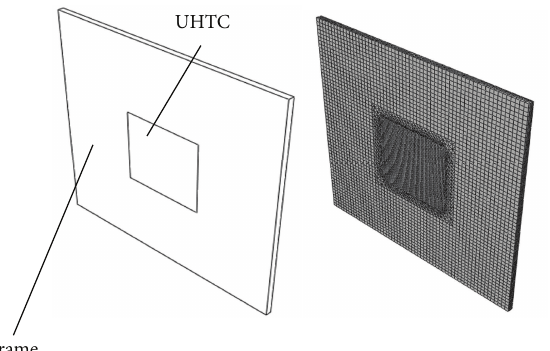
Figure 1: Geometric model and the finite element mesh. Table 1: Temperature-dependent material properties of HfB